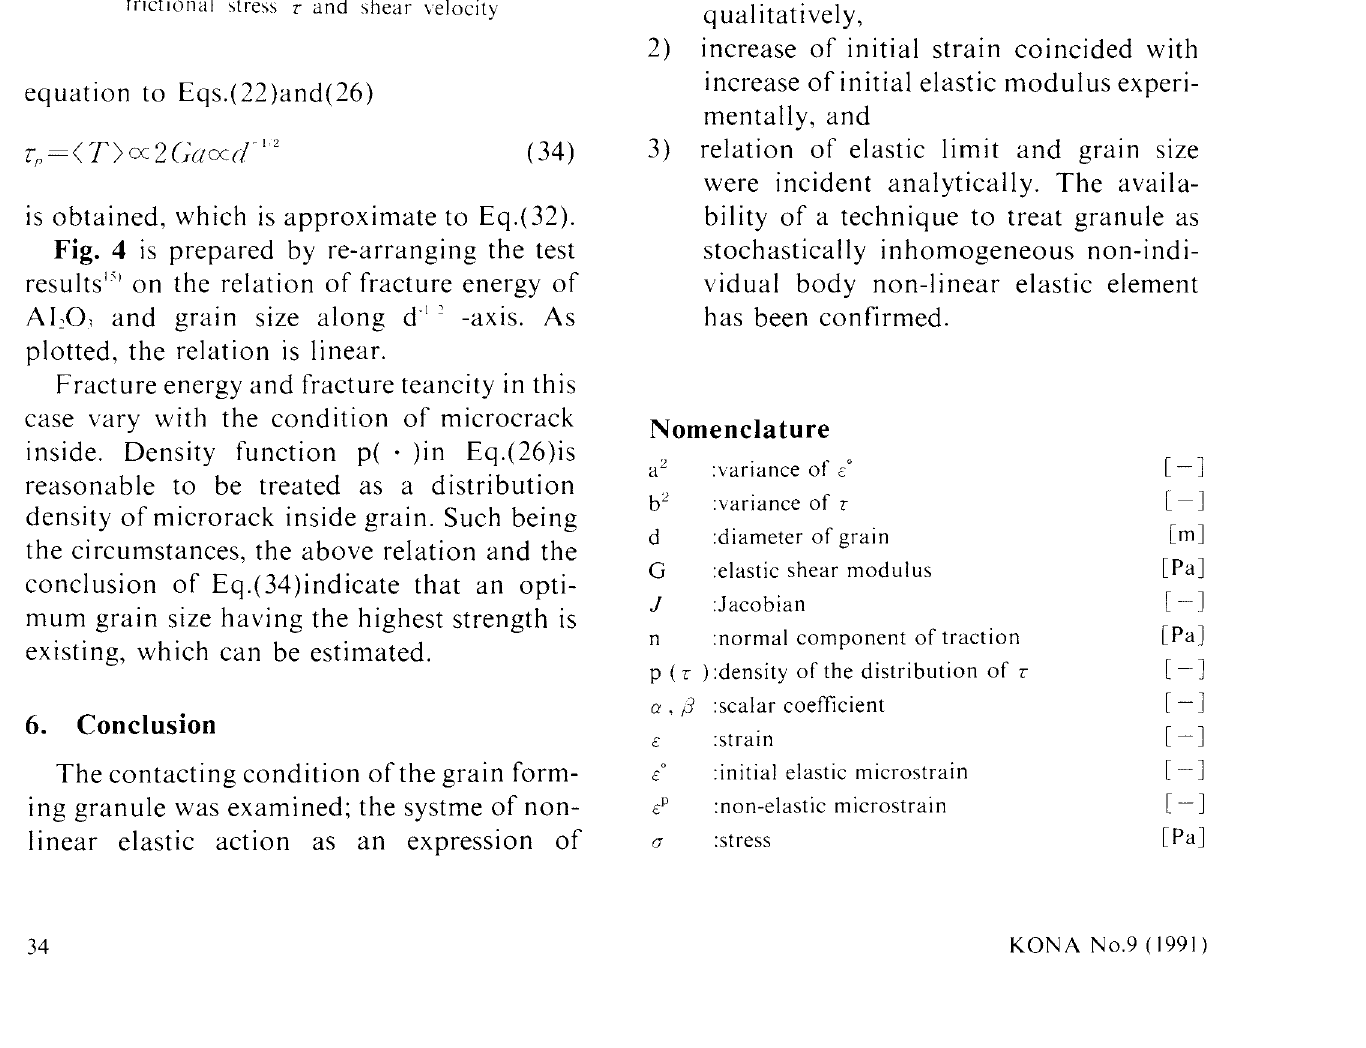
Fig. 3 The relation bet\\een initial pressure p1. frictional stress r and shear velocity